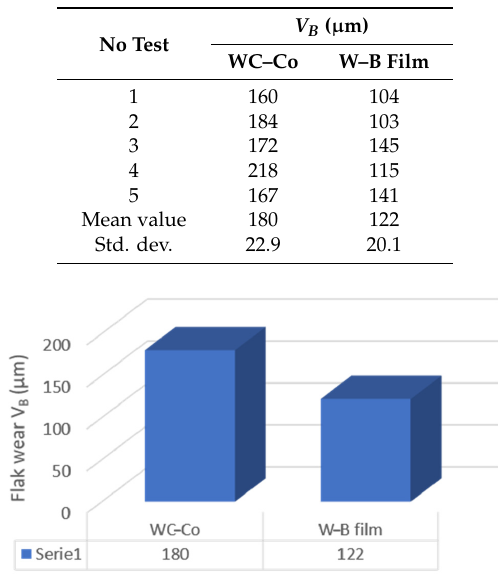
Table 6. Results of flank wear V B after turning test for WC–Co insert and W–B coated insert.